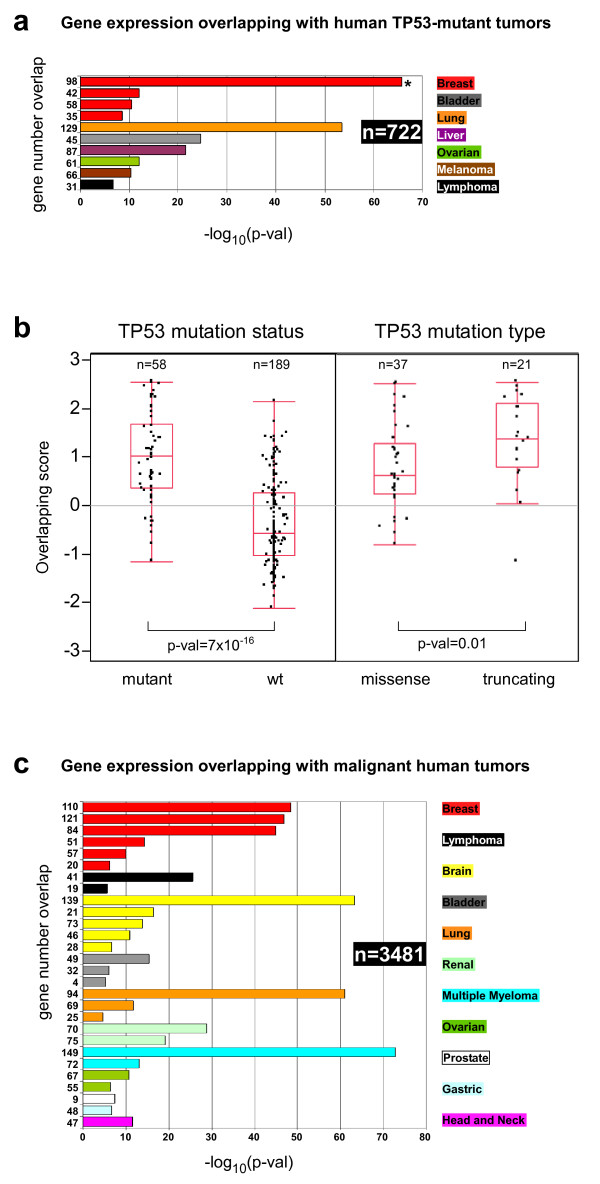
Overlapping of mouse and human tumors. (a) Gene expression overlapping between mouse tumors and human samples with TP53 mutations from 7 different cancer types is shown. n: total number of human tumors analyzed. Bar plots represent the significance of the overlap between overexpressed genes in tumors of p53-deficient mouse and genes overexpressed in human tumor samples with TP53 mutations (p-val, Fisher's exact test). Numbers at left represent the gene number overlap. Aside the plot is represented the color codes for each cancer tissue. Asterisk represents the most significant overlapping. (b) Mouse tumors as models for missense and truncating TP53 mutations. Gene expression values of the 98 genes overlapping between the mouse tumors and the breast cancer samples from Ivshina et al. [26] (asterisk in panel a) with TP53 mutations (overlapping score; mean = 0, stdv = 1) were plotted depending on the TP53 mutation status (left) or the mutation type (right). Number of tumor samples and significance of mean difference is shown. (c) Gene expression overlapping between mouse tumors and human samples with poor outcome from 11 different cancer types is shown. n: total number of human tumors analyzed. Bar plots represent the significance of the overlap between overexpressed genes in tumors of p53-deficient mouse and genes overexpressed in human tumor samples with poor outcome (p-val, Fisher's exact test). Numbers at left represent the gene number overlap. Aside the plot is represented the color codes for each cancer tissue.